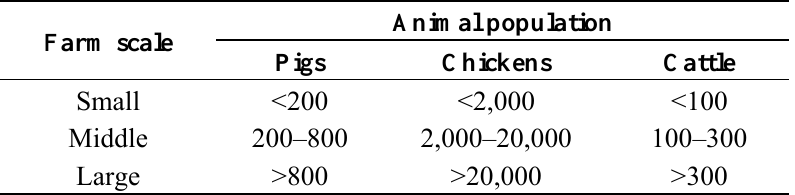
Table 1. Animal population in farms of different